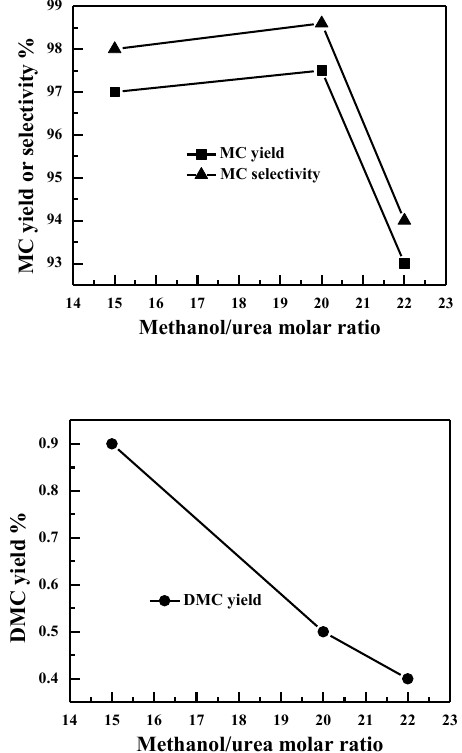
Figure 8. Effect of methanol/urea molar ratio on yield and selectivity of 1 and 2 . Reaction conditions: 1 g urea, 0.1 g TiO 2 /SiO 2 , 170 ◦ C, and 6